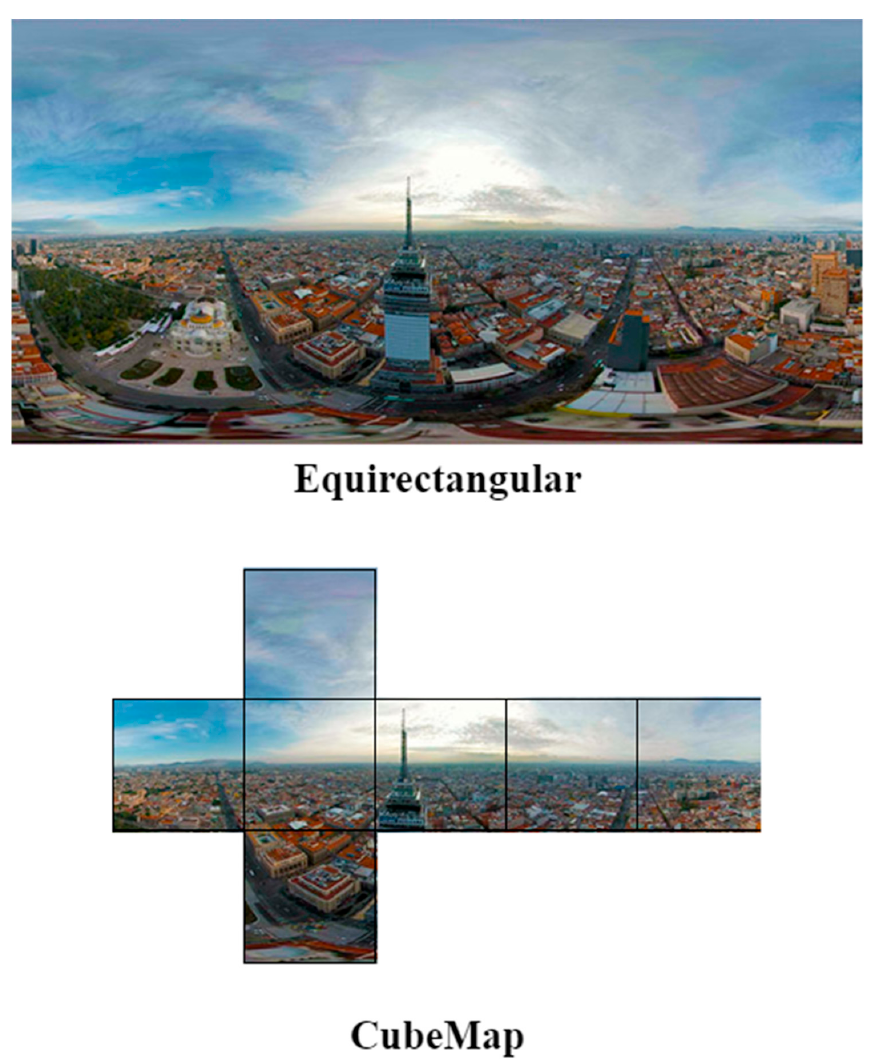
Figure 4. Equirectangular projection (EMP) and cube map projection (CMP) comparison.